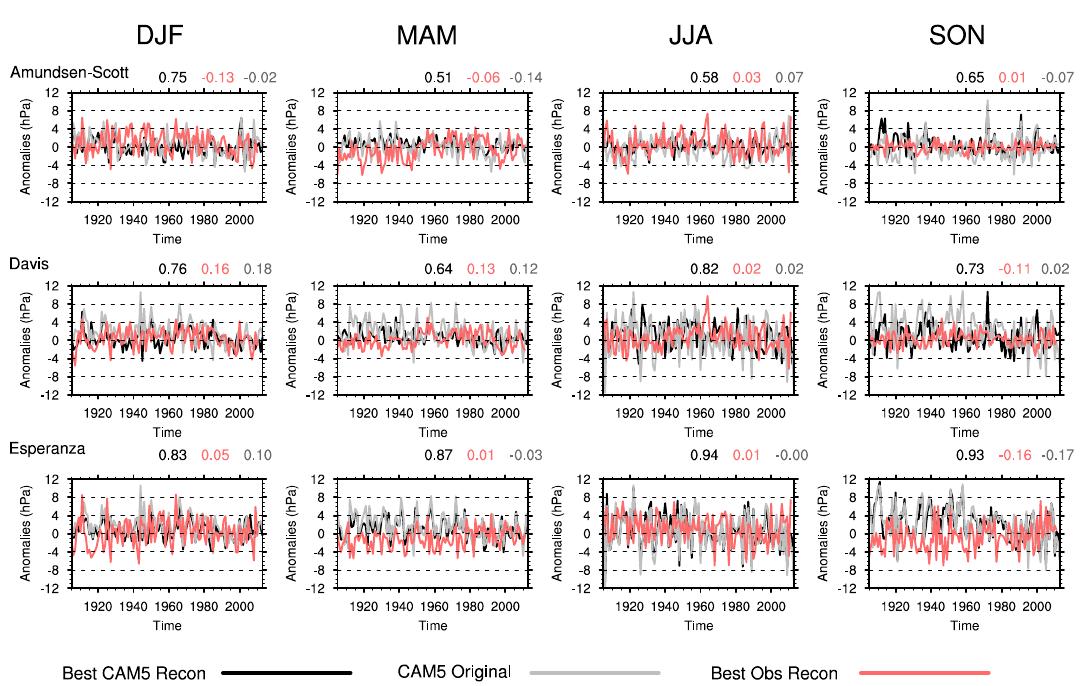
Figure 3. Pressure anomaly timeseries of CAM5 best reconstruction (same as from Figure 2) along with CAM5 original data for the same ensemble member and the best observational-based reconstruction [28]. Seasonal pressure anomalies are plotted for 3 di ff erent Antarctic stations—Amundsen-Scott (South Pole, representing the Antarctic interior), Davis (representing coastal East Antarctica) and Esperanza (representing the Antarctic Peninsula). Correlation values between these datasets are also listed at the top of each figure. Values in black represent the correlation between the best CAM5 reconstruction and the original CAM5 dataset, red values indicate the correlation between the best CAM5 reconstruction and the best observational reconstruction and grey values represent the correlation between the original CAM5 data and the best observational reconstruction. Each value is produced by correlating these datasets over the full time period for each individual station and season.